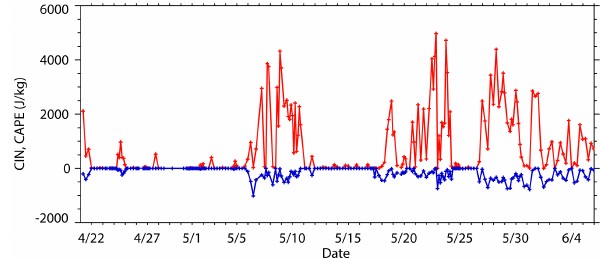
Figure 7. Time series of CAPE MU (red) and CIN MU (blue) at the ARM C1 over the course of the MC3E field campaign, using cor- rected sounding humidity. Three distinct active convective periods are easily identifiable (6–11 May, 18–23 May and 26 May–6 June) with high CAPE and low CIN